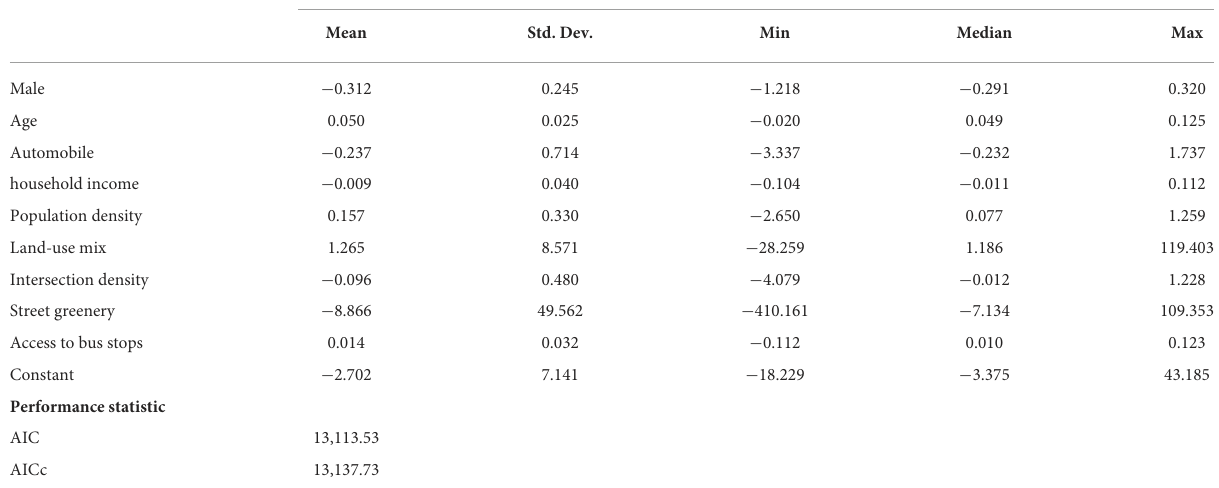
TABLE 3 Local modeling